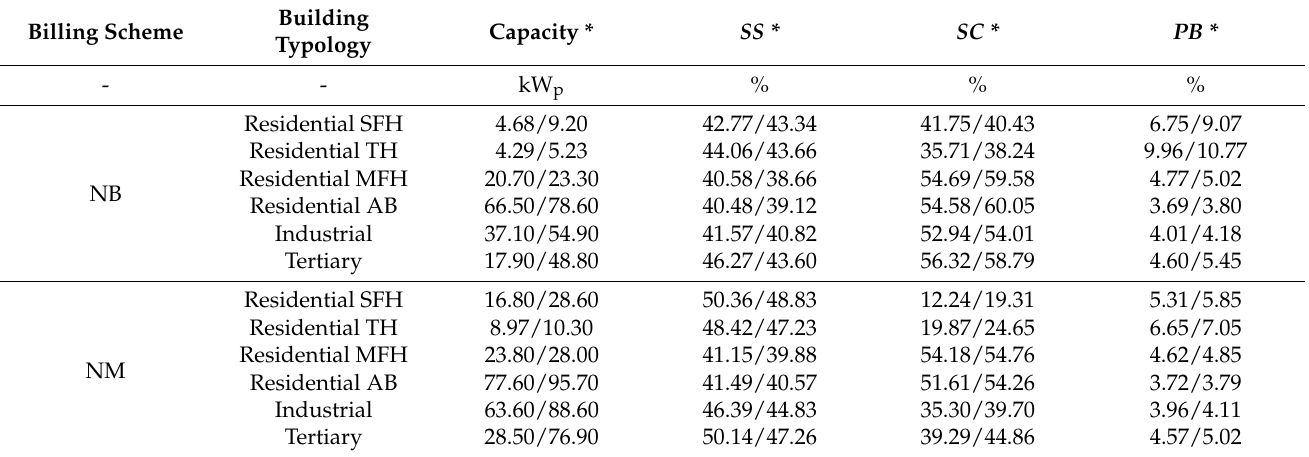
Table 6. Main statistical values of PV capacity, SS , SC and PB by building typologies and billing scheme for the base load profile scenario.